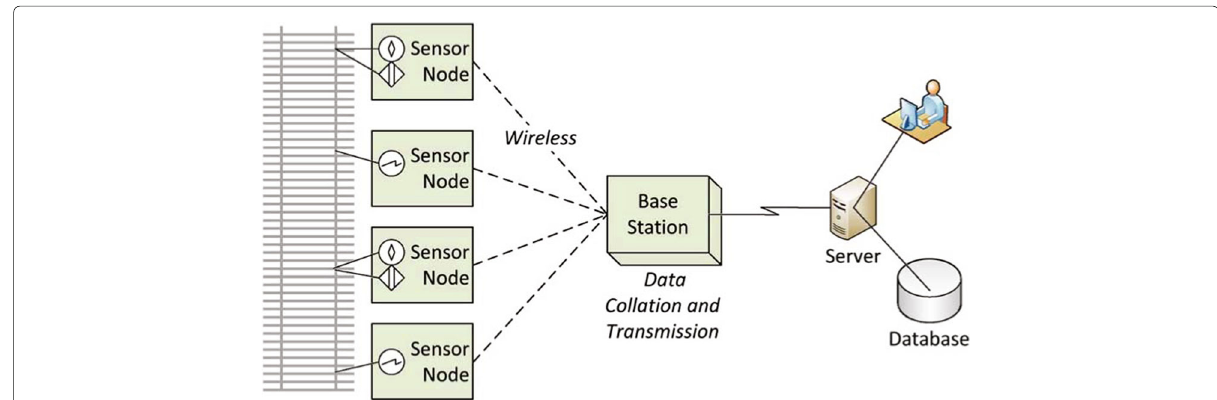
Fig. 2 IWSN application of conditioning monitoring in the railway